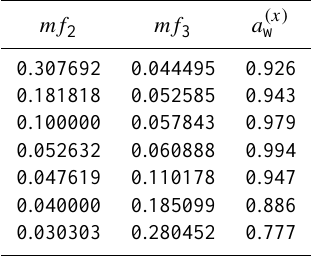
Table A4. Bulk water activity measurements of the system water solution compositions are given in mass fractions ( mf j ).